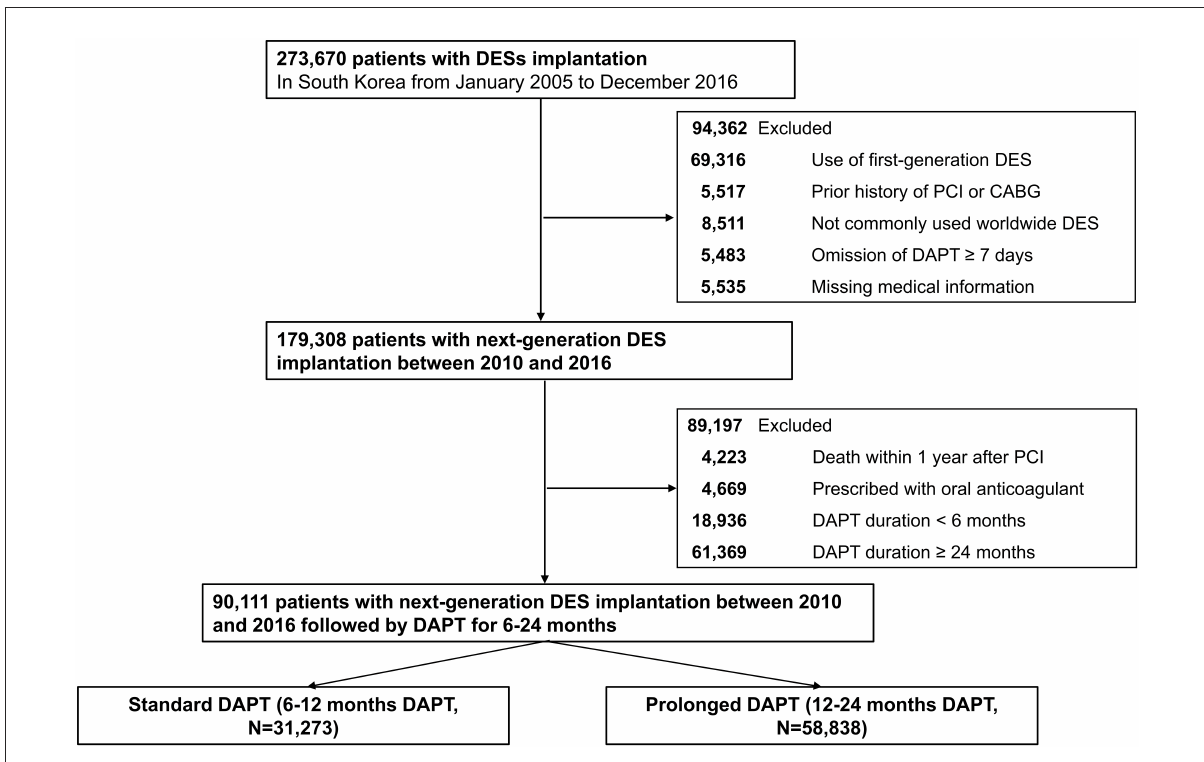
FIGURE1 A flowchart of the study population. DES, drug-eluting stent; CABG, coronary artery bypass graft; PCI, percutaneous coronary intervention; DAPT, dual antiplatelet therapy; Standard DAPT, DAPT between 6 and 12 months; Prolonged DAPT, DAPT between 12 and 24